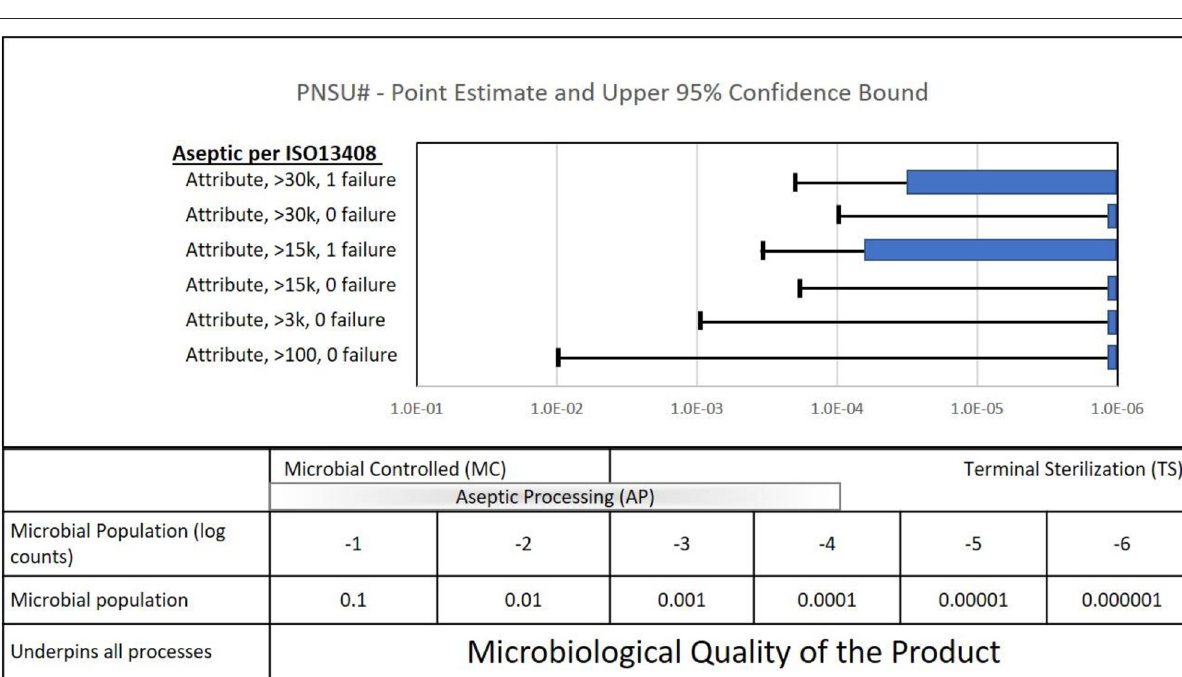
intervals ≤ 10 − 6 (a lesser mathematical value, not a lesser sterility